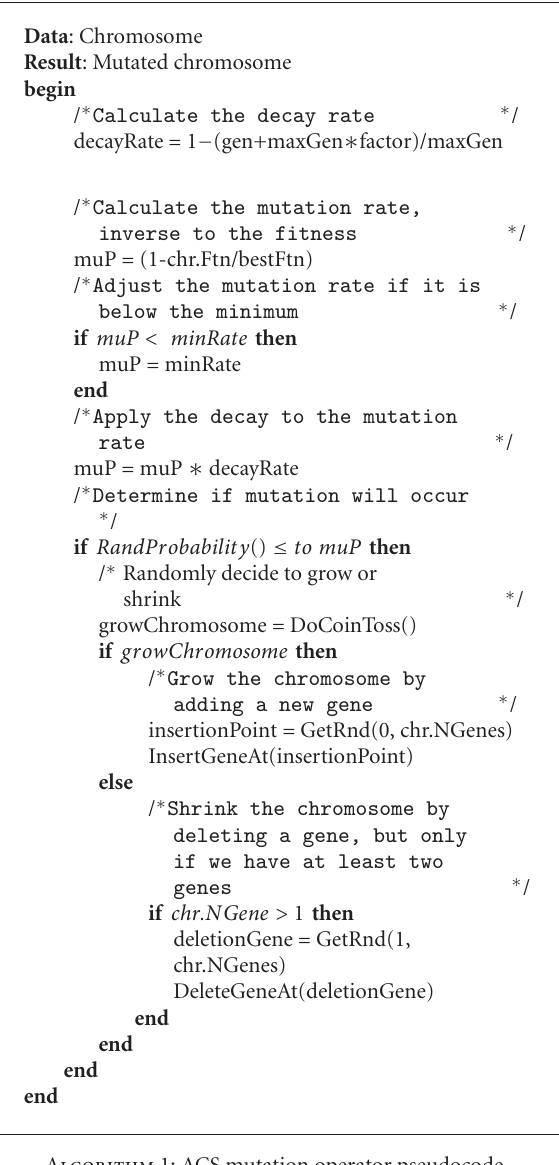
Algorithm 1: ACS mutation operator